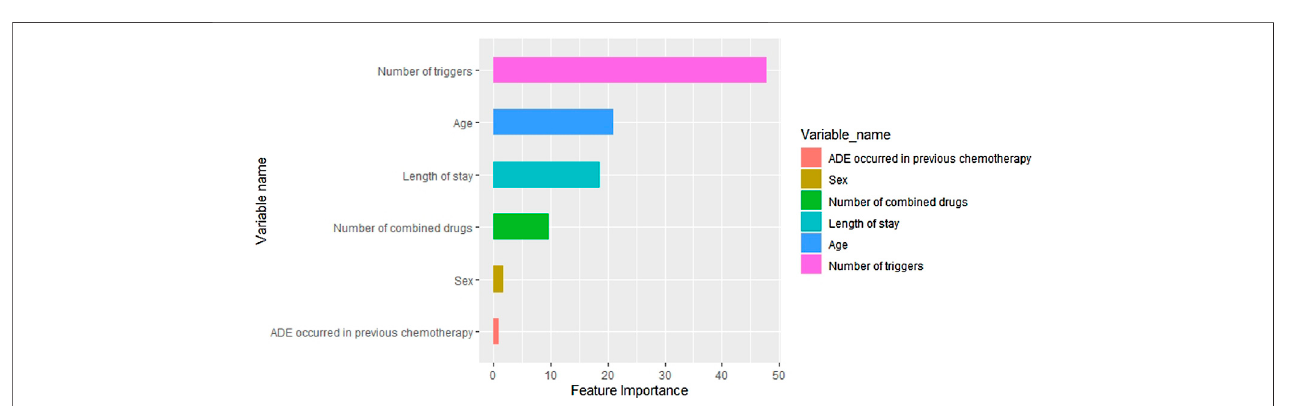
FIGURE 7 | Ranking of variable importance in the GBDT